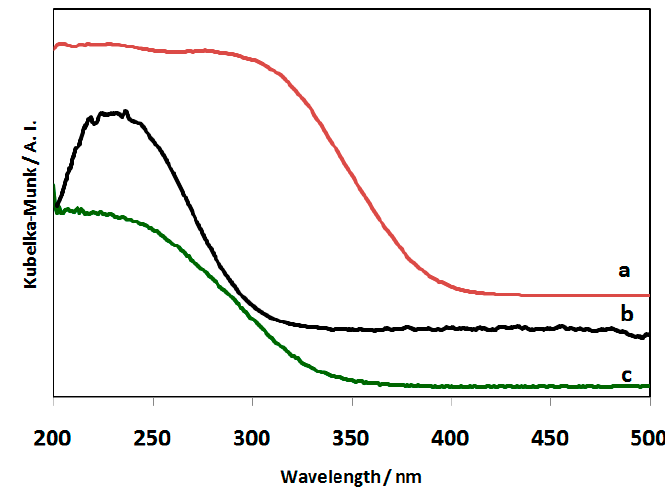
Figure 1. DRS UV-vis pattern of: reference bulk Nb 2 O 5 solid ( a ); freshly calcined NbO x -SiO 2 catalyst ( b ); and NbO x -SiO 2 catalyst after four catalytic cycles and calcination at 500 °C under dry air ( c ).